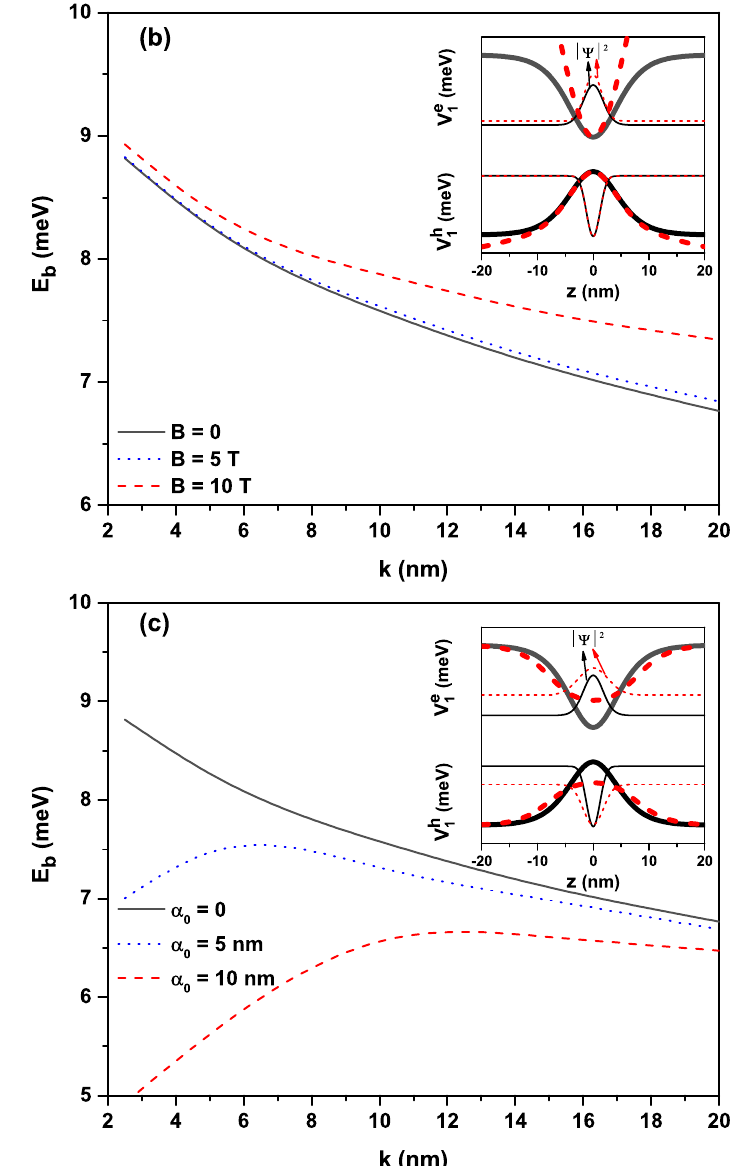
Figure 1. Heavy-hole exciton binding energy as a function of the k well width parameter for con- ( h ) ν 1 sech 2 ( z / k ) in the presence of the external fields: ( a ) electric finement potential V 1 ( z e ( h ) ) = − V e 0 field ( B = 0 and α 0 = 0), ( b ) magnetic field ( F = 0 and α 0 = 0), and ( c ) intense laser field ( F = 0 and B = 0), respectively. The inset in each figure shows the changes in the confinement potentials (thick lines) and the square of the ground state wavefunction (thin lines) for the electron and hole and considering the lowest and highest value of the corresponding field in each panel. Results are for ν 1 =